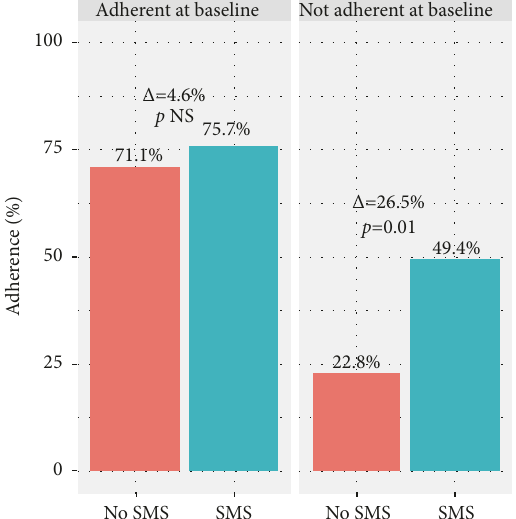
Figure 3: The increase in proportion of adherent participants after text message reminders is greater in the nonadherent at baseline group. Source: